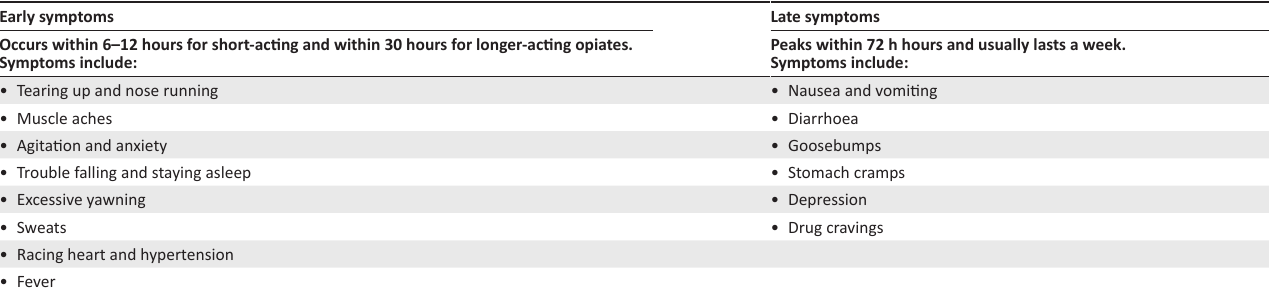
TABLE 2-A3: Opioid withdrawal symptoms. 136